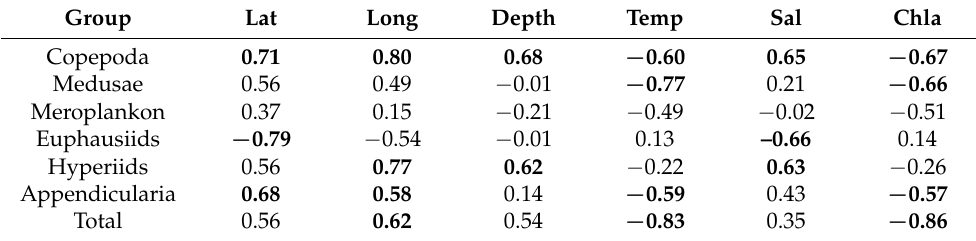
Table 3. Spearman’s rank correlation coefficients between environmental variables and the abundance of common mesozooplankton groups in the eastern Barents Sea in May 2016. Bold font indicates significant coefficients after Holm–Bonferroni correction ( p < 0.05): Lat—latitude;